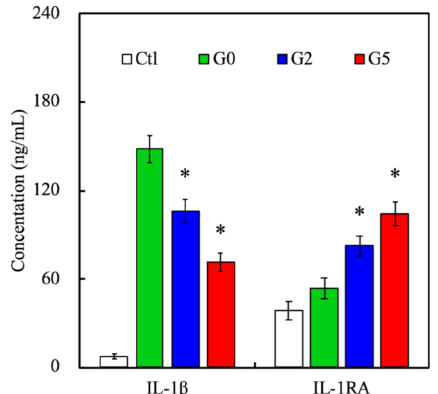
Figure 7. IL-1 β and IL-1RA expressions of hDPSCs cultured on the GR-contained MSCS scaffolds for 24 h. * indicates a significant difference ( p < 0.05) from G0. Data presented as mean ± SEM, n = 6 for each